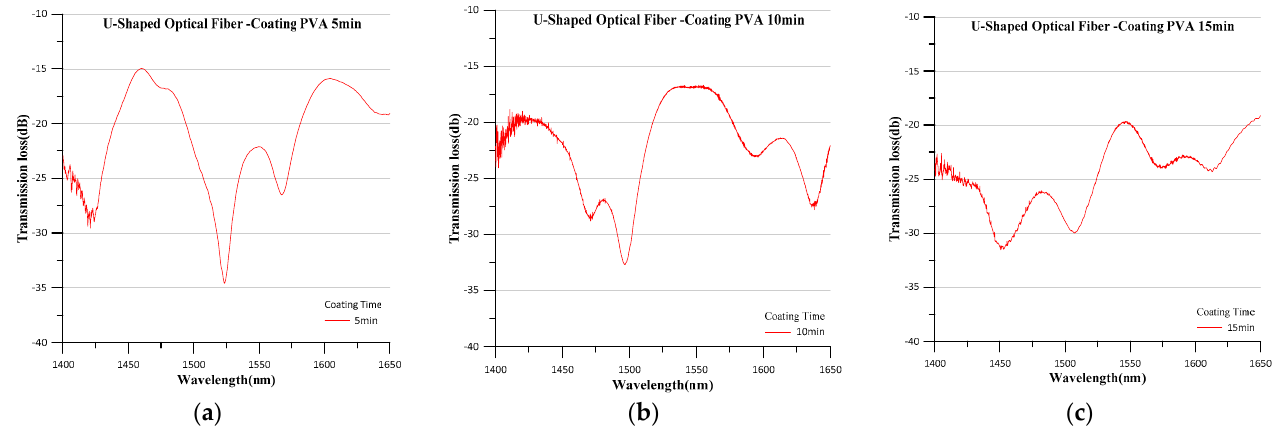
Figure 6. Spectra generated by the electrospun PVA-coated sensors with electrospinning durations of ( a ) 5 min, ( b ) 10 min, and ( c ) 15 min.